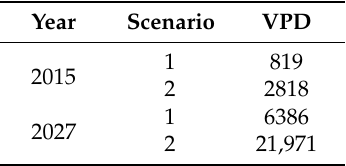
Table 3. Number of vehicles affected by flooding each